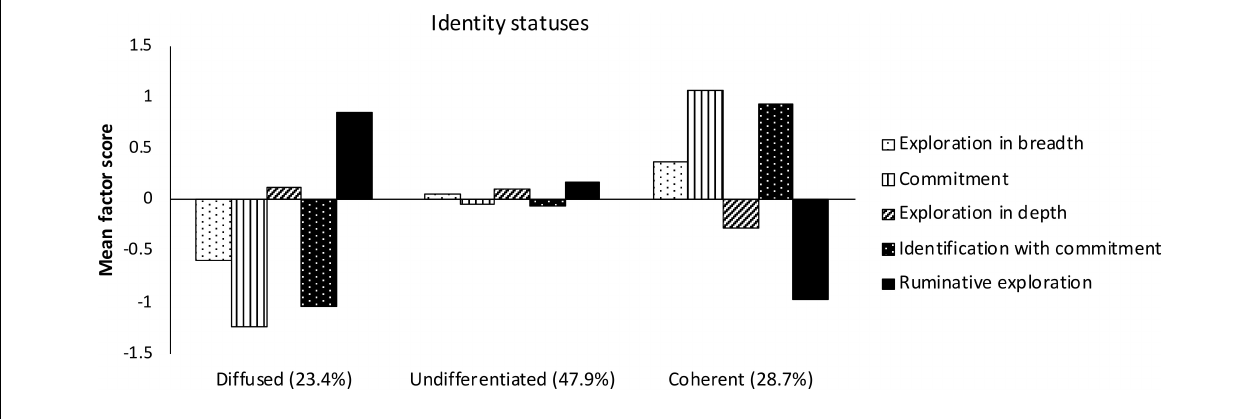
FIGURE 1 | Identity profiles based on factor means of identity processes ( N =